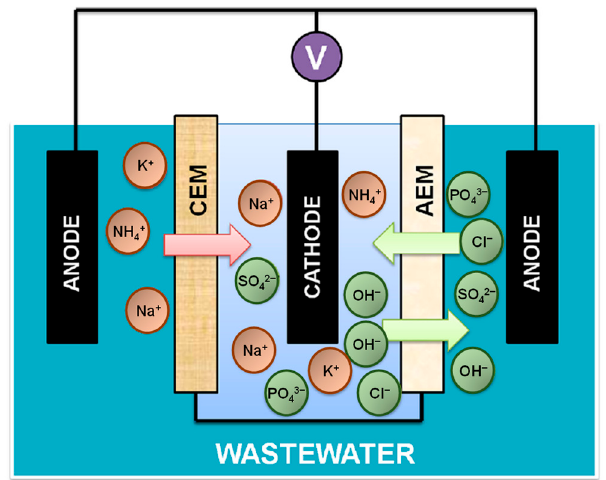
Figure 6. Schematic diagram of Removing-Recovering Bio-Electrochemical System (R 2 -BES) for recovery of nitrogen and phosphorus from wastewater. Abbreviations: CEM (cation exchange membrane); AEM (anion exchange membrane). Adapted from the ref. [102].